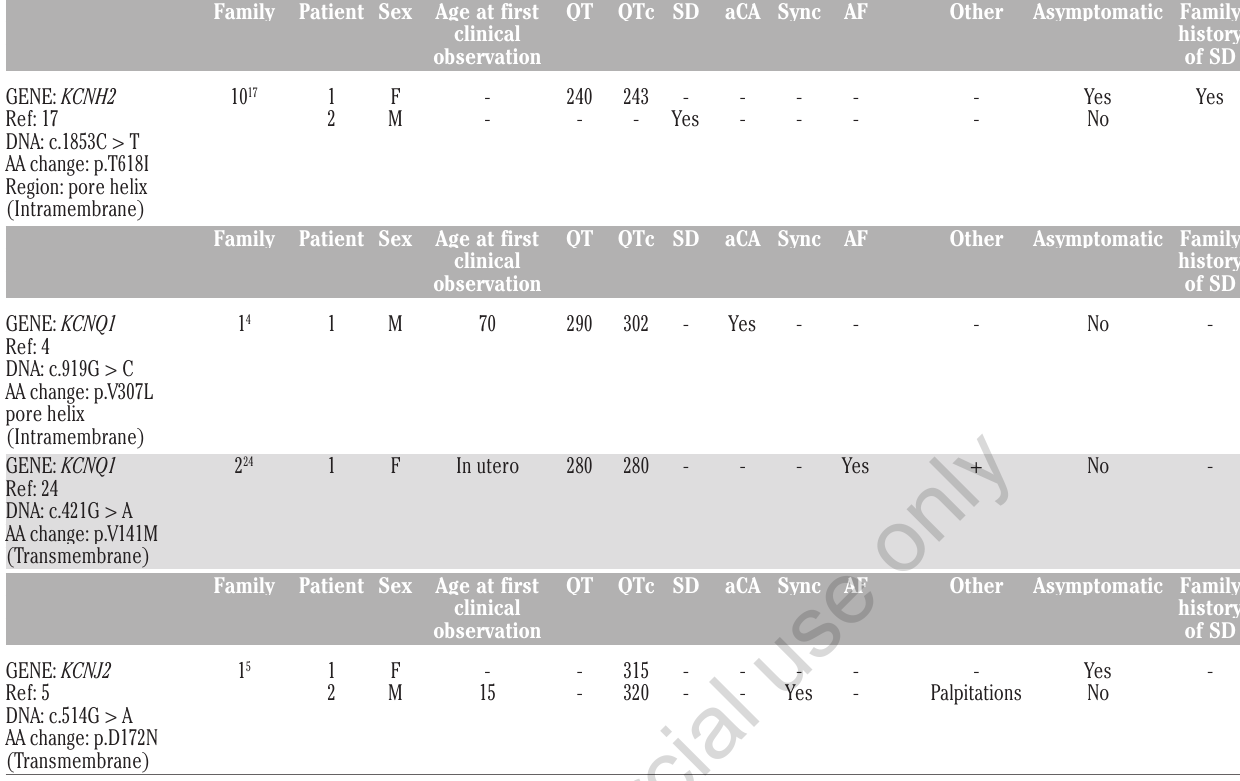
Table 1. Mutations in the potassium channel encoding-genes linked to short QT syndrome. For each subject QT/QTc interval, age at first clinical observation and clinical characteristics are reported. Family Patient Sex Age at first Other Asymptomatic Family clinical history observation